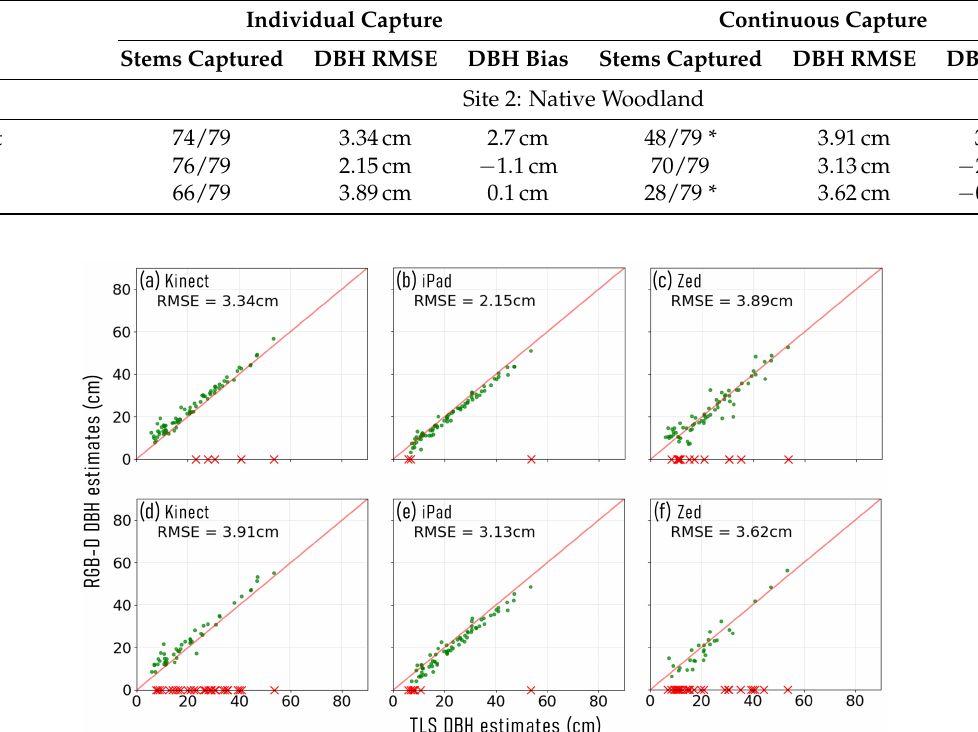
Figure 4. Stem diameter at breast height (DBH) estimates captured at site 2 (S1), in native